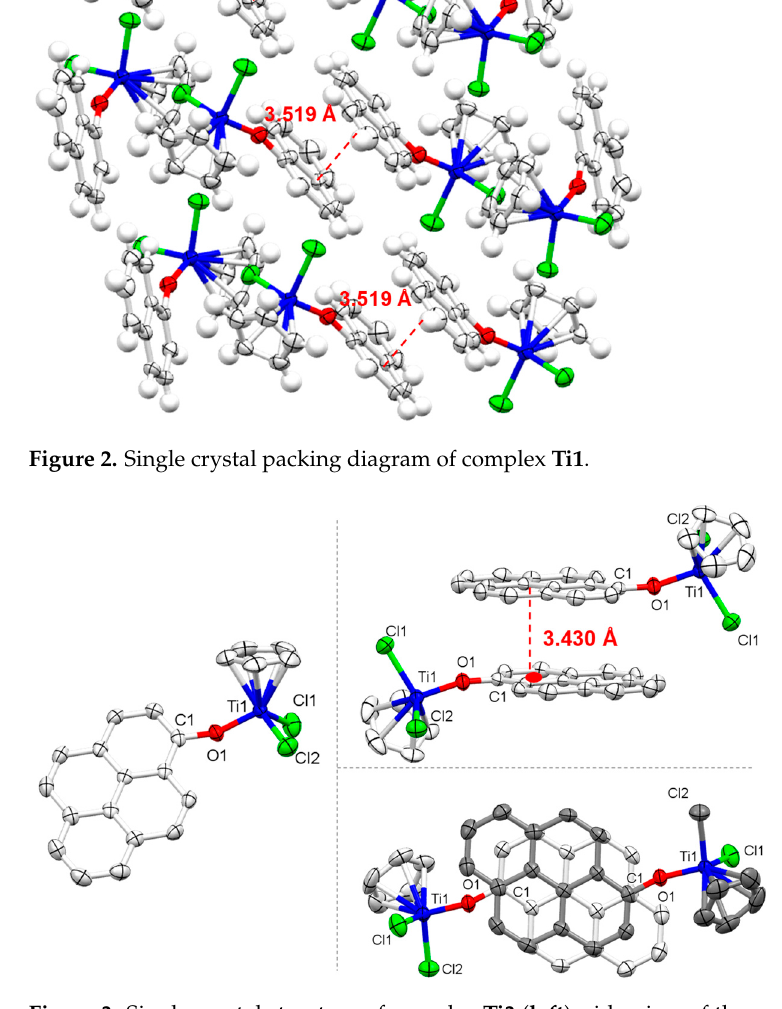
Figure 3. Single crystal structure of complex Ti3 ( left ); side-view of the π - π stacked dimer ( upper right ); top-view of the π - π stacked dimer ( lower right , the two pyrenyl rings were drawn in different color to give a clearer distinguishability). Selected bond length (Å) and angles (°): Ti1-O1, 1.7794(18), Ti1-Cl2, 2.2528(8), Ti1-Cl1, 2.2737(9), O1-C1, 1.362(3), O1-Ti1-Cl2, 102.22(7), O1-Ti1-Cl1, 103.00(7), C1-O1-Ti1, 158.26(18).